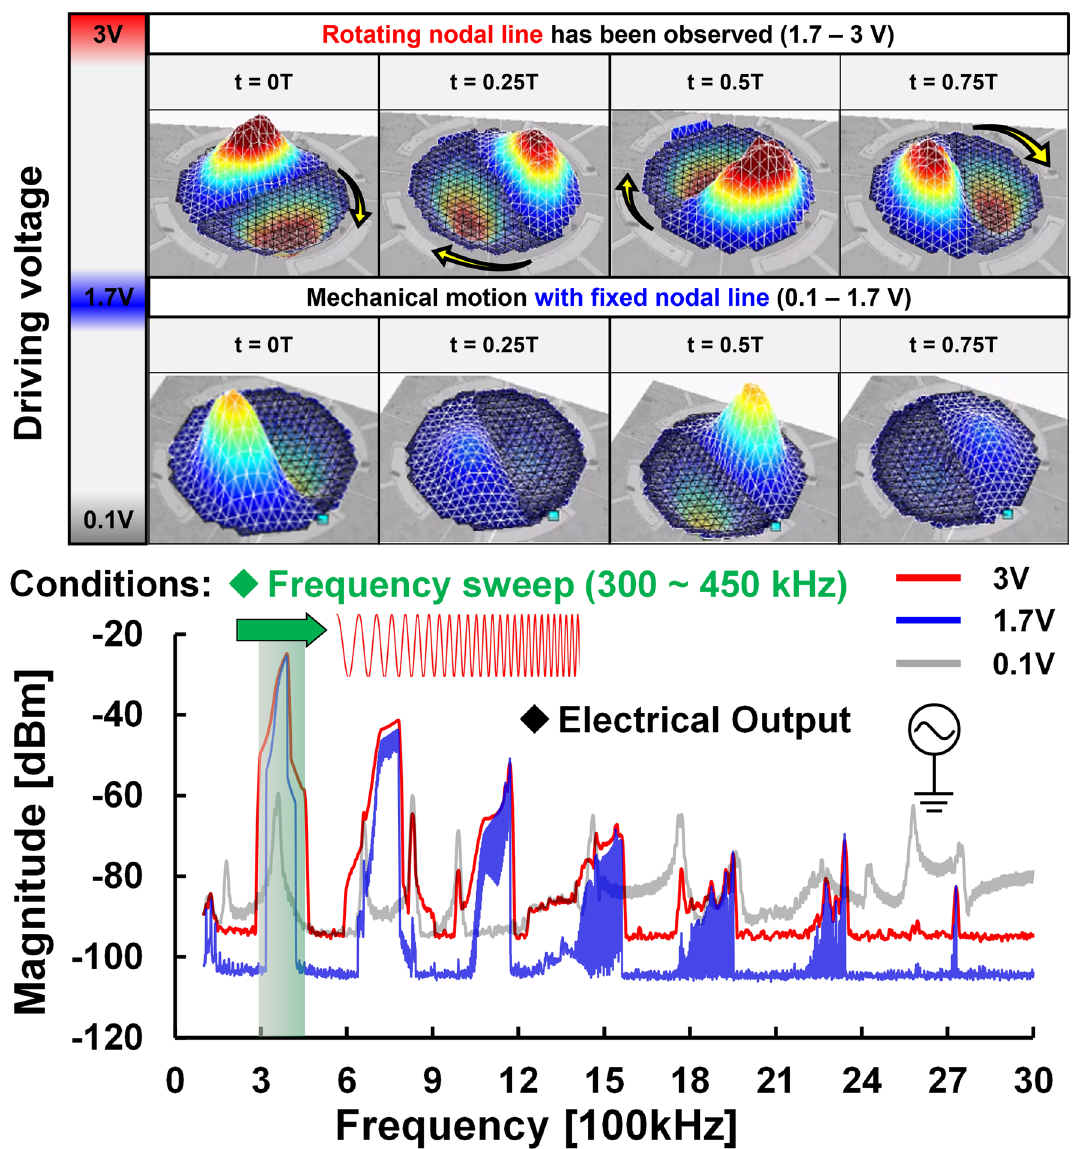
Figure 3. Comparison of the different driving chirp signals near desired normal (1,1) mode: The time segments of the motion of the normal (1,1) mode show two different nonlinear states representing before and after rotation. The mechanical rotation motion takes place above a threshold voltage of 1.7